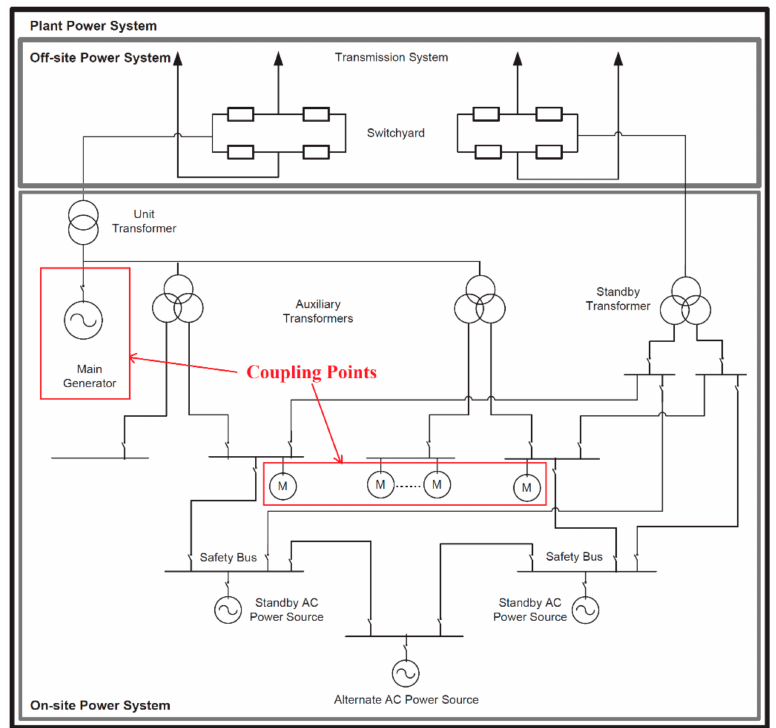
Figure 2. Typical electrical layout of an NPP based on the IAEA safety standard